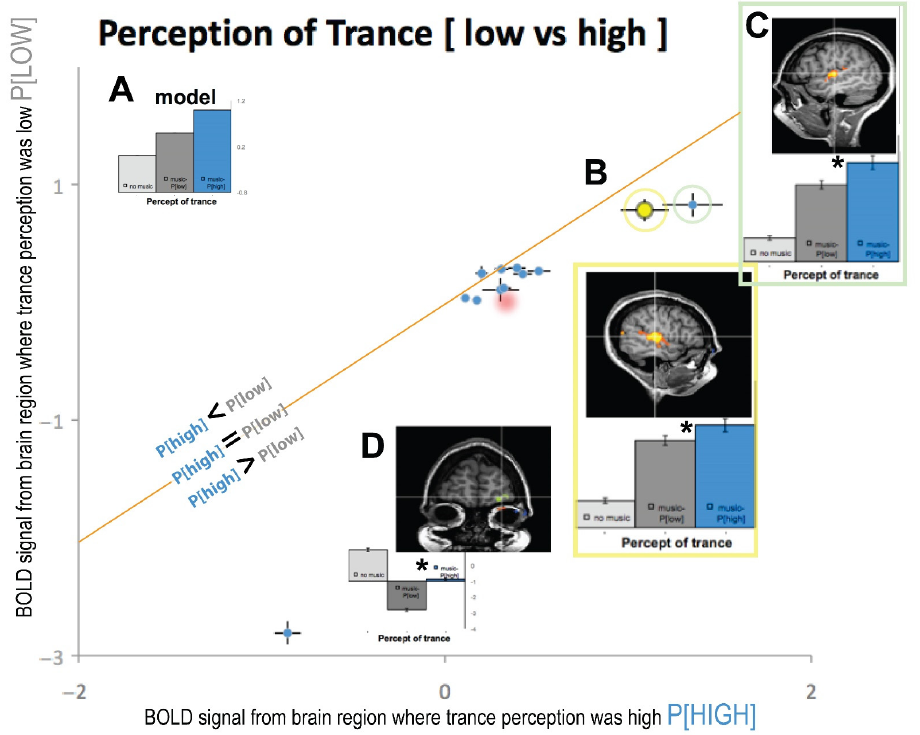
Figure 3. ( A ) The Model BOLD signal if trance has a P [ HIGH ] modulated by the music signal. The diagonal orange line represents where low and high trance perception is equal with data below and above the line as the differences. ( B ) Same brain area as in Figure 1A from the right auditory cortex. ( C ) Left auditory cortex bar plots and location. ( D ) Orbitofrontal cortex bar plot and spatial location, Talairach coordinates; x = − 24; y = 63; z = 5. Brodmann Area 10. Other data points that were examined from functional ROIs clustered near the orange line. Red drop shading for two data points signifies anatomical regions from [3]. *- denotes significant p <